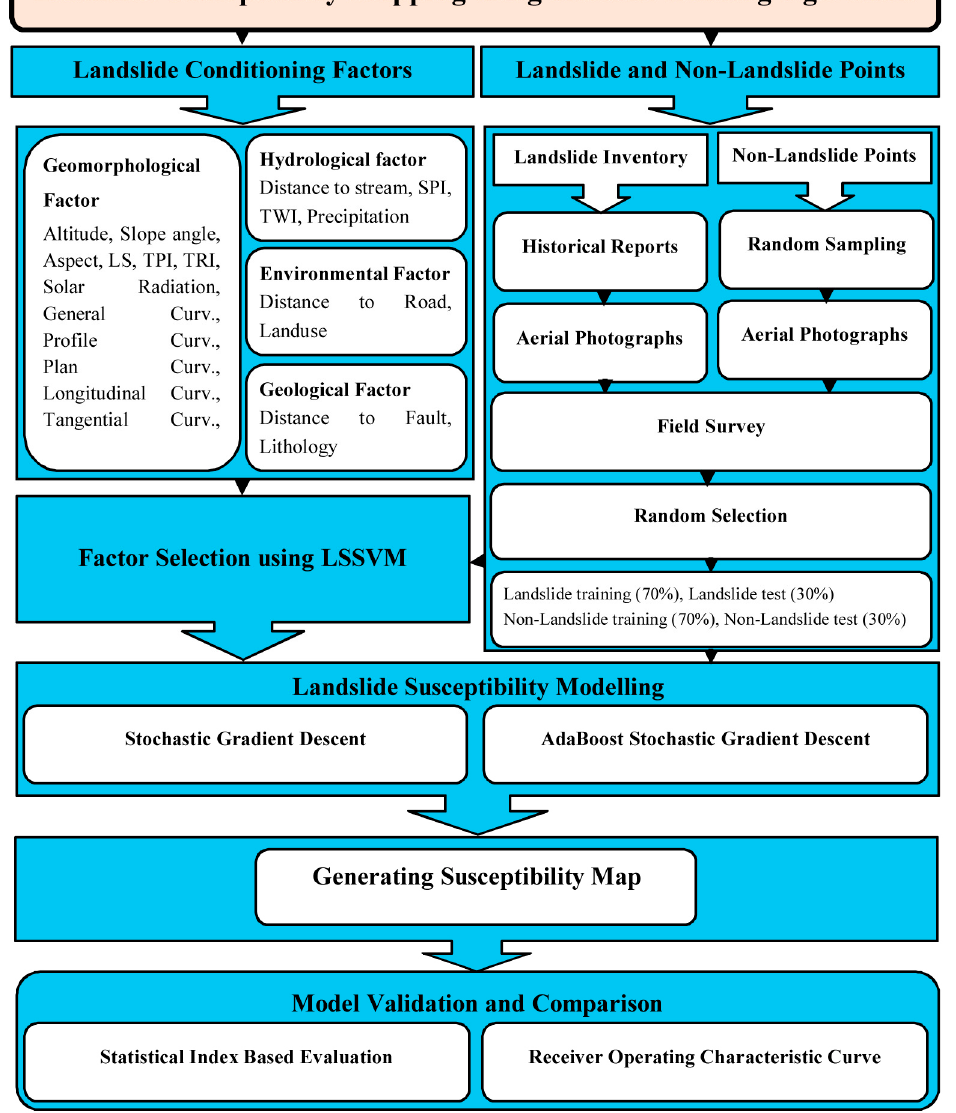
Figure 3. The overall flowchart of landslide susceptibility modeling in the Sarkhoon watershed.